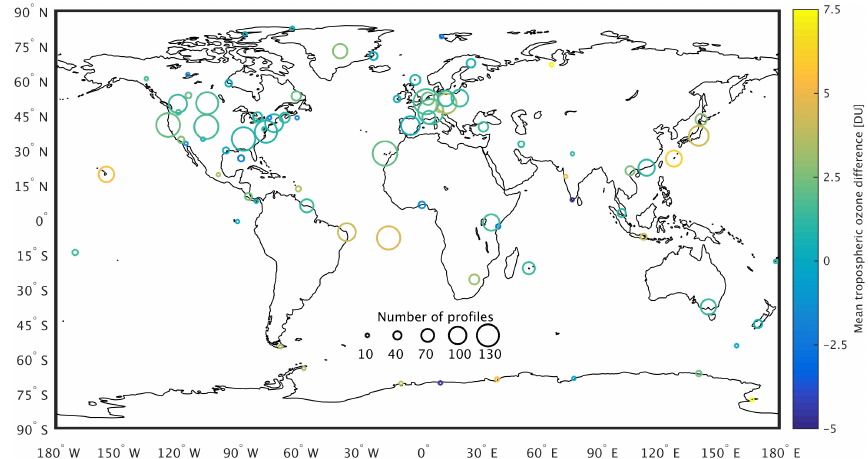
Figure 7. The locations of the ozonesondes used in this study. The size of circles denotes the number of successful validations for the two- band case in 2004–2008, and the color denotes mean bias between the tropospheric ozone column from OMI and the ozonesonde convolved with the OMI averaging kernels.